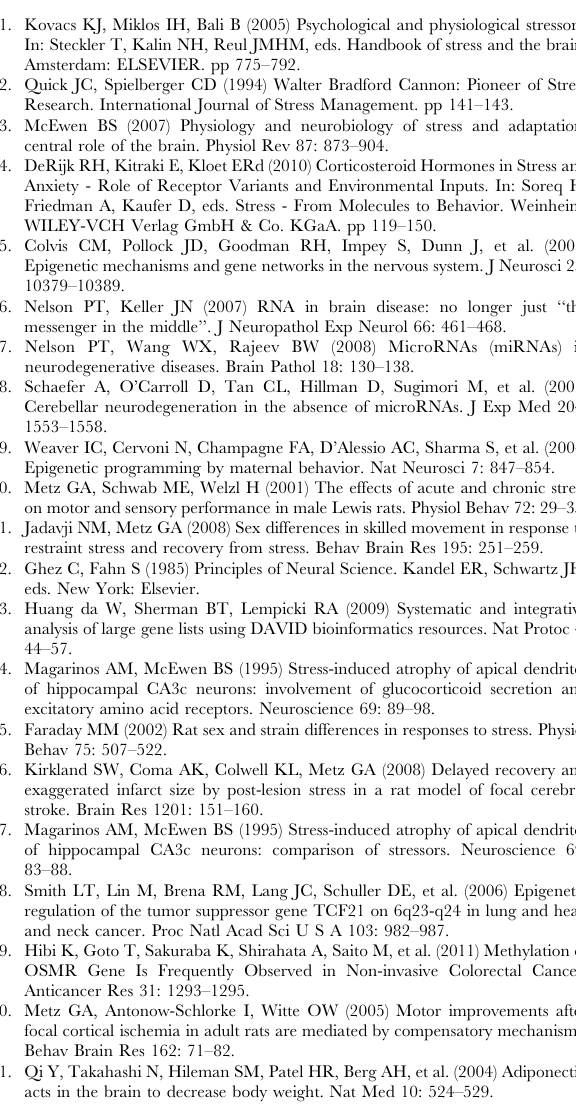
Table S9 qRT-PCR data of miR-709 expression in hippocampus. Table S10 qRT-PCR data of miR-186 expression in prefrontal cortex. Table S11 qRT-PCR data of miR-709 expression in prefrontal cortex. Table S12 Primers and PCR conditions for sq-RT-PCR, qRT-PCR, and